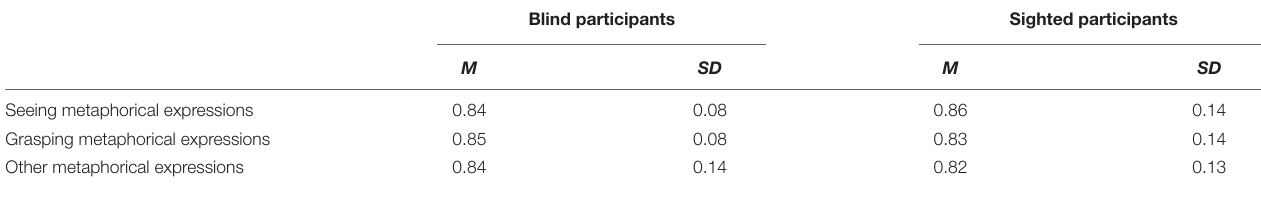
TABLE 1 | Mean proportions of correct answers for the comprehension of metaphorical expressions by blind and sighted participants, Experiment 1. Blind participants Sighted participants M